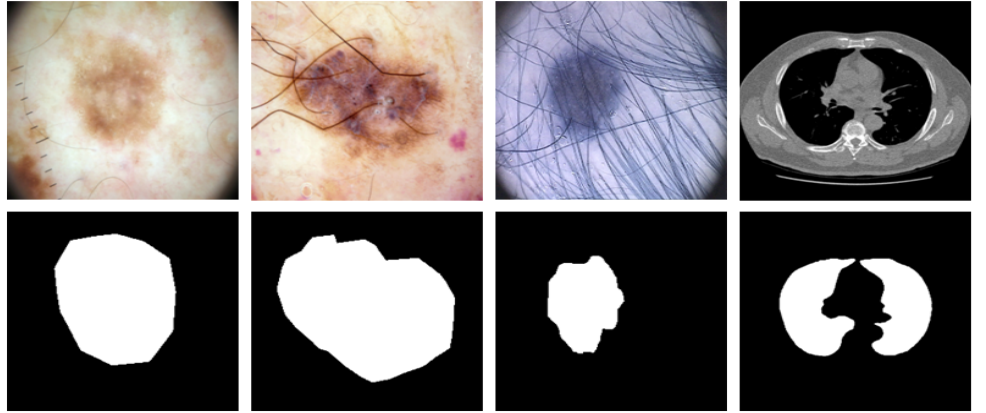
Figure 1. Some examples of medical images with their corresponding segmentation images. The three left images show the skin lesion segmentation whereas the right one indicates the segmentation of lung